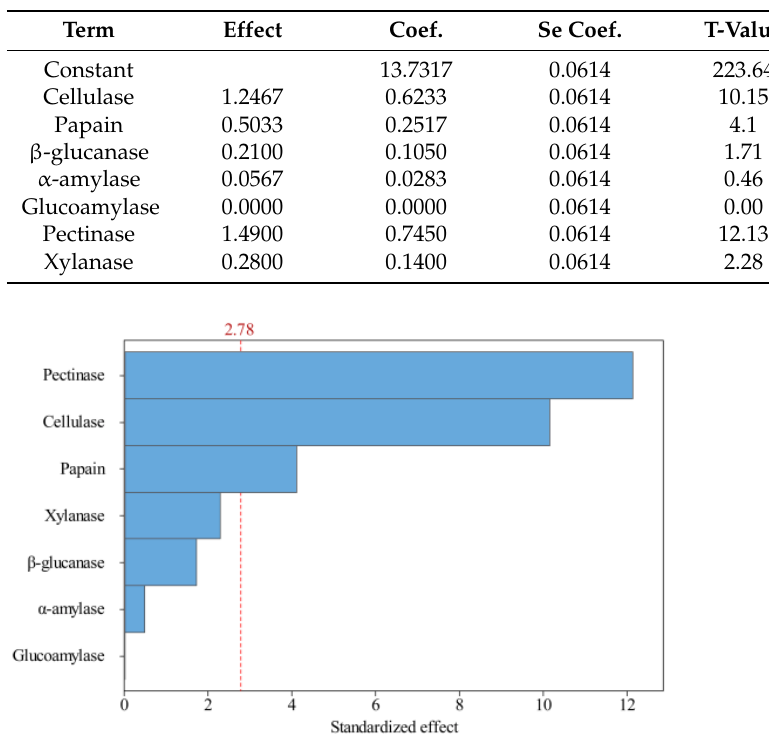
Table 4. ANOVA for PBD model based on oil yield.